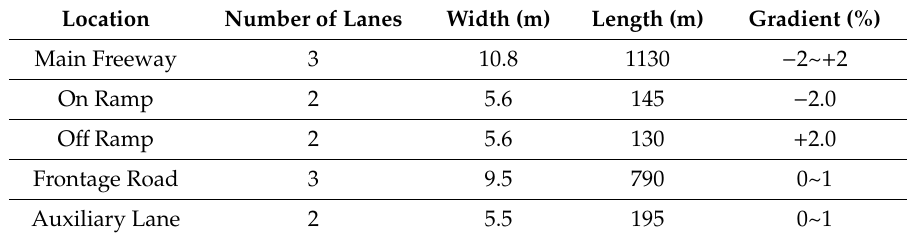
Figure 2. Geometric drawing of the study area. Table 1. Summary of study area geometry.